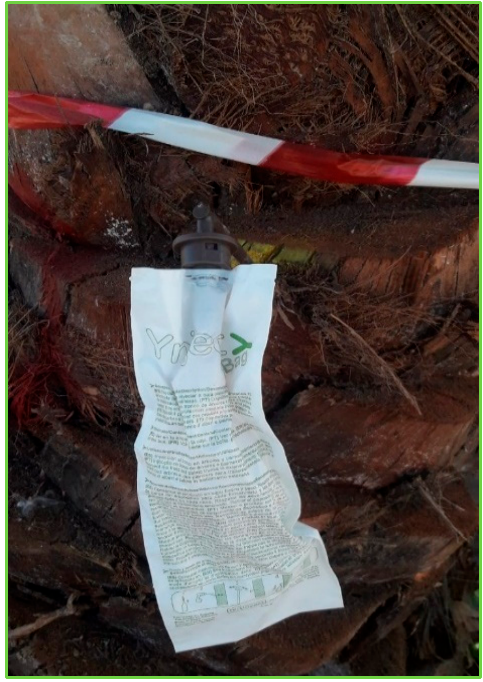
Figure 1. A balloon filled with fungal solution was inserted into each hole in the date palm.